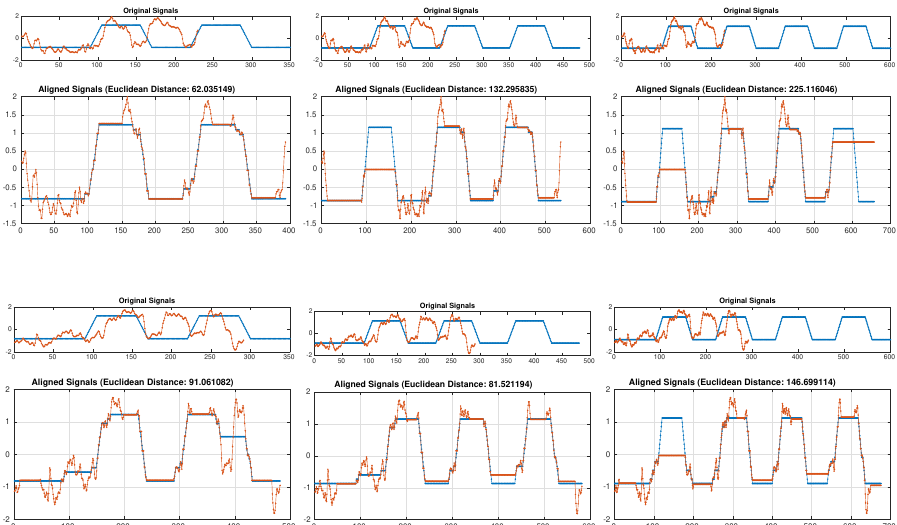
Figure 5. Automatic identification of the number of repetitions. A curve for each patient (red color) is aligned with reference curves for 2, 3 and 4 repetitions (blue). The one with minimal average Euclidean distance is selected. The figure shows Smiling exercise (distance between mouth corners on y-axis, transformed time on x-axis). Two repetitions were selected for the patient with id = 4 (top) and three repetitions for the patient with id = 15.